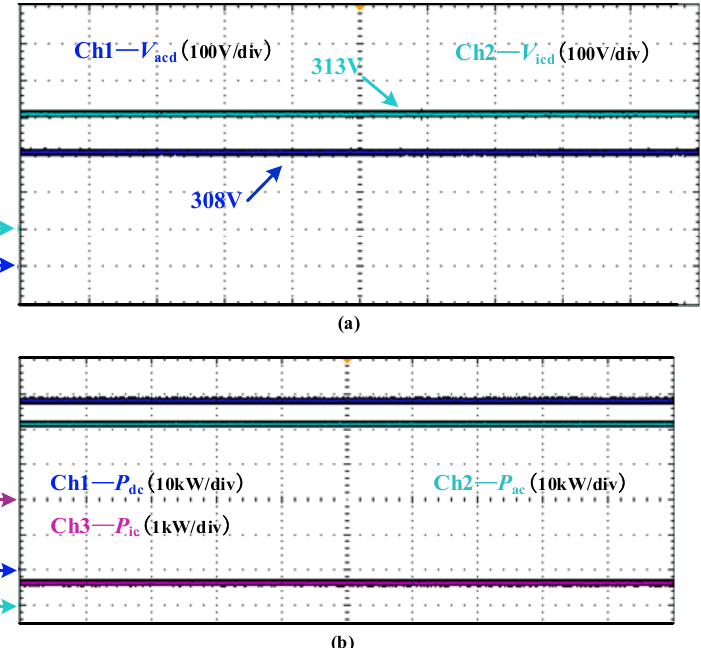
Figure 7. System operation condition without the line impedance estimation ( x -axis: time, 1 s/div; y -axis: magnitude of the measured signal): ( a ) magnitude value of V ac and V ic ; ( b ) output power of sub-grid and IC.